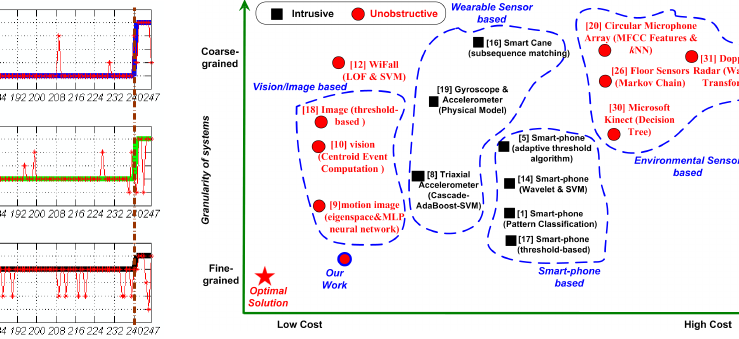
Figure 17: Detect fall events in action paths the Y-axis from 1 to 5 represent action categories (i.e., sit-